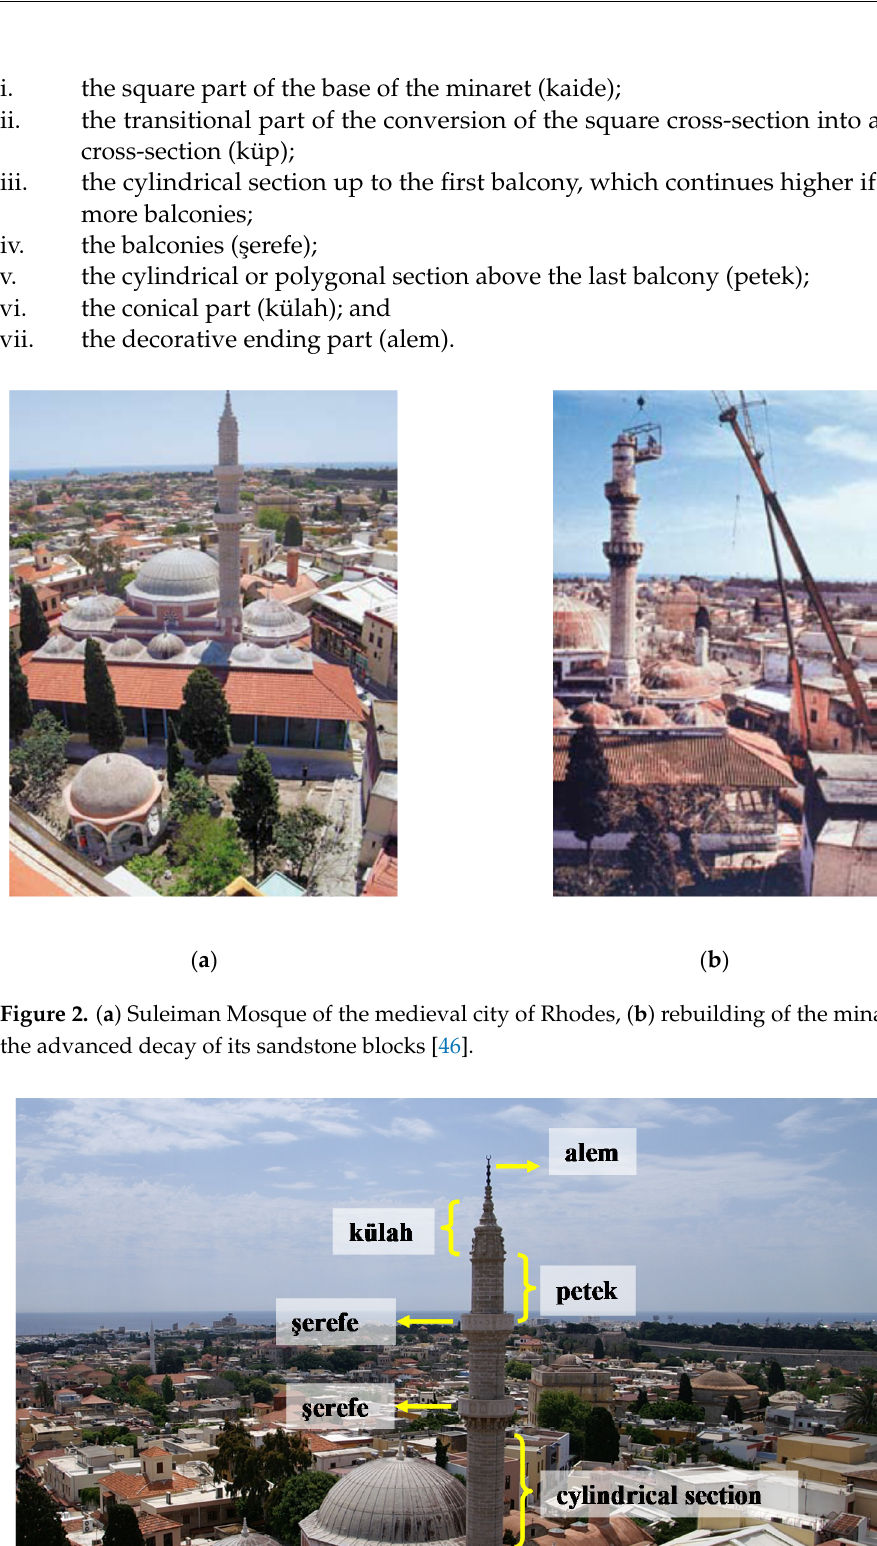
Figure 4. Architectonic façade and cross-sections.